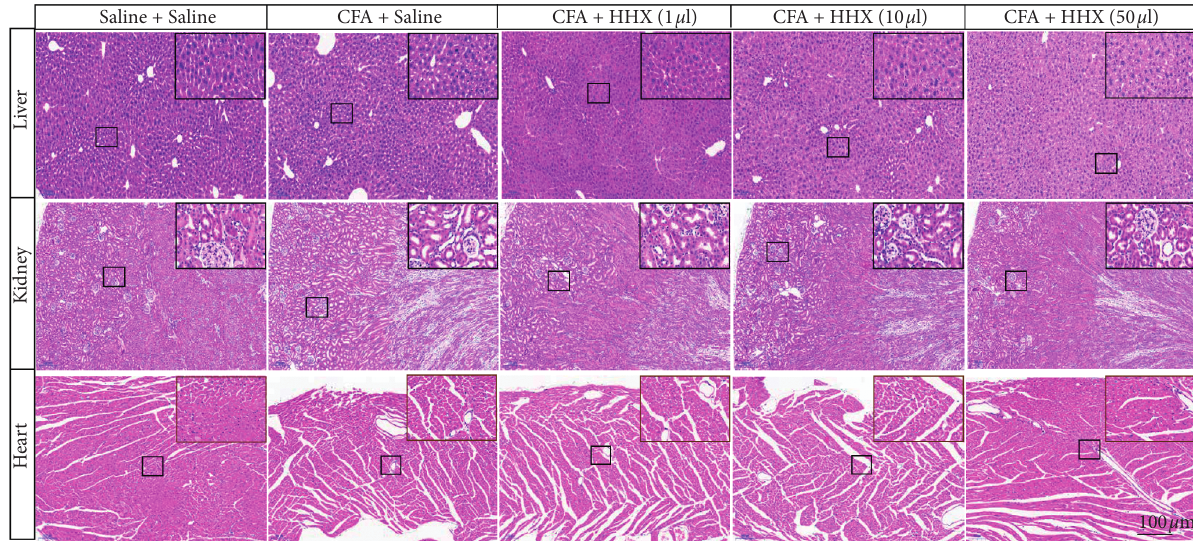
Figure 4: The histological structural of the liver, kidney, and heart was observed in H&E-stained sections. There were no significant differences between the different